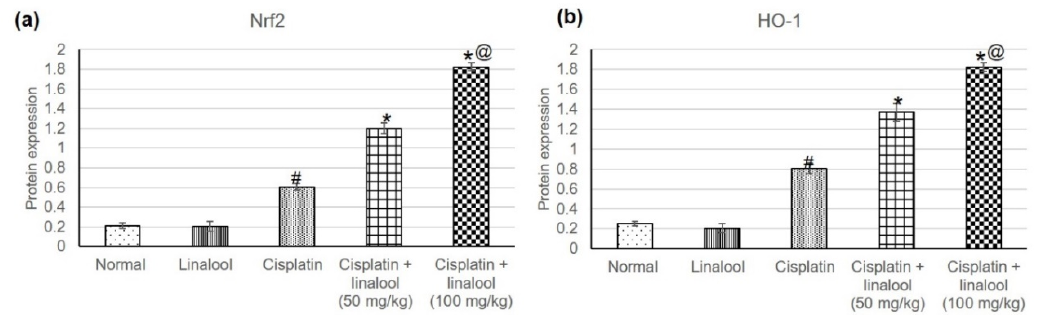
Figure 2. Effects of pre-treatment with linalool (50 and 100 mg/kg) for 14 days on the Nrf2/HO-1 signaling pathway in cisplatin-induced acute kidney injury: ( a ) Nrf2 and ( b ) HO-1 levels. All values are expressed as mean ± SD. #, statistically significant from normal group, *, statistically significant from cisplatin-only group, @, statistically significant from cisplatin + linalool 50 mg/kg group ( p < 0.05) using one-way ANOVA followed by Tukey’s post-hoc analysis.